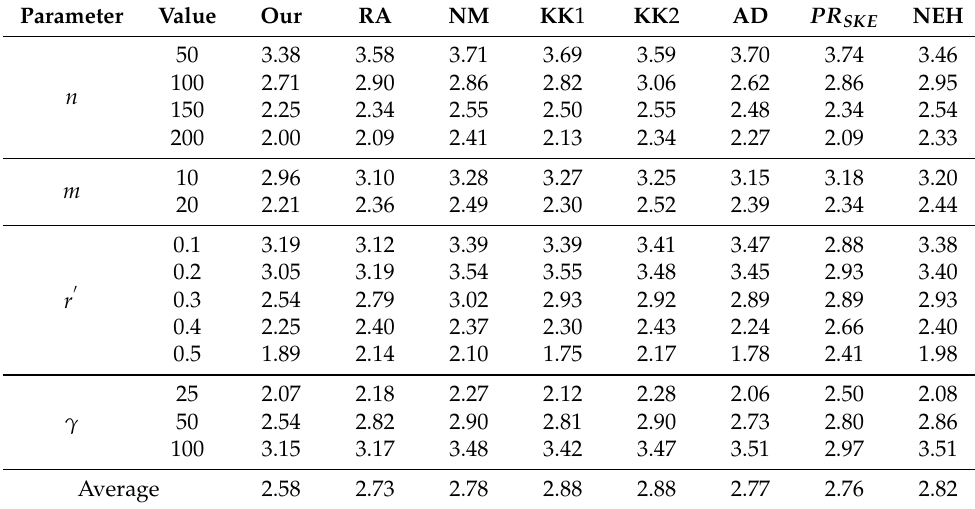
Table 11. Computational results for the NEH algorithm: comparison with the most promising proposals in the